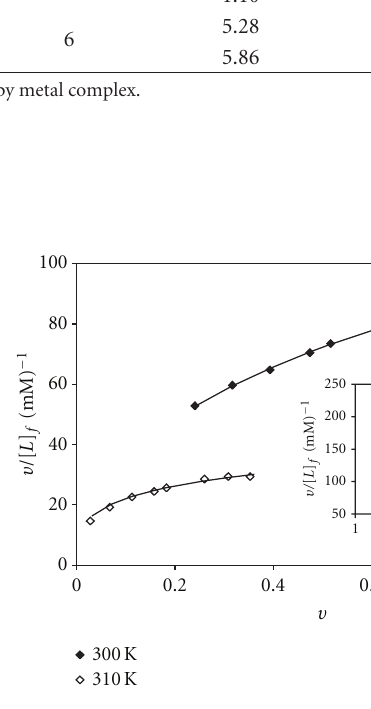
Figure 6: Scatchard plots for binding of [Pt(bpy)(Oct-dtc)]NO 3 and the inset for [Pd(bpy)(Oct-dtc)]NO 3 to CT-DNA. On substituting the above experimental data ( ν and [ L ] f